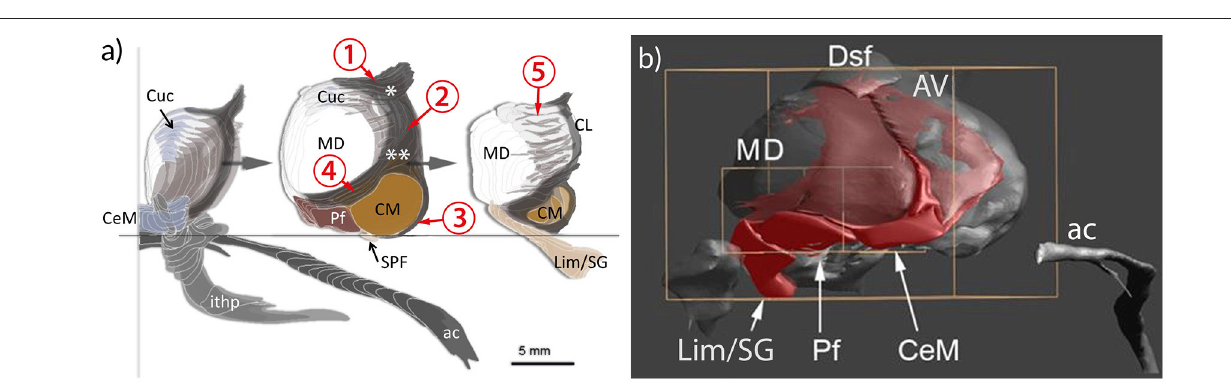
smaller areas in other